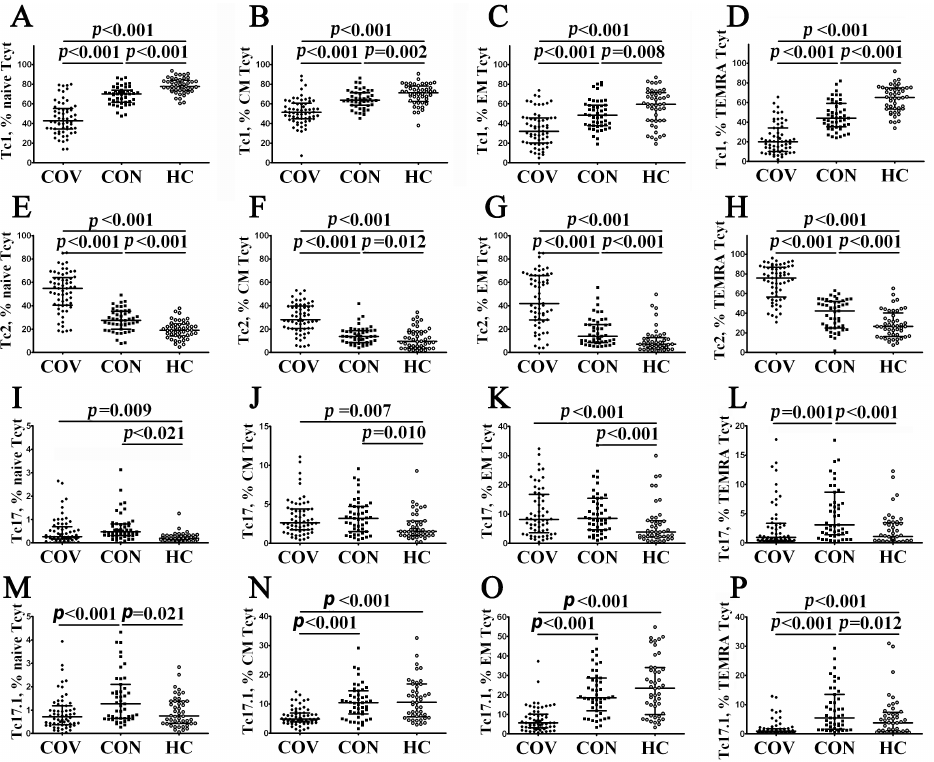
Figure 7. 7 Figure 7. Imbalance in peripheral blood Tc1, Tc2, Tc17, and Tc17.1 cells in major CD8+ T cell subsets with varying patterns of CD45RA and CD62L expression in acute and convalescent COVID-19 patients. Scatter plots ( A – D ), ( E – H ), ( I – L ), and ( M – P ) show the relative numbers of Tc1 (CCR6 − CXCR3+), Tc2 (CCR6 − CXCR3 − ), Tc17 (CCR6+CXCR3 − ), and double-positive Tc17.1 (CCR6+CXCR3+) cells within ‘naïve’ (CD45RA+CCR7+), central memory (CM, CD45RA − CCR7+), effector memory (EM, CD45RA − CCR7 − ), and terminally differentiated CD45RA-positive effector memory (TEMRA, CD45RA+CCR7 − ) CD8+ T cells, respectively. Black circles denote patients with acute COVID-19 (COV, n = 71); black squares—convalescent COVID-19 individuals (CON, n = 51); white circles—healthy control (HC, n = 46). Each dot represents individual subjects, and horizontal bars depict the group medians and quartile ranges (Med (Q25; Q75)). In Figure 7, the statistical analysis was performed with the Mann–Whitney U